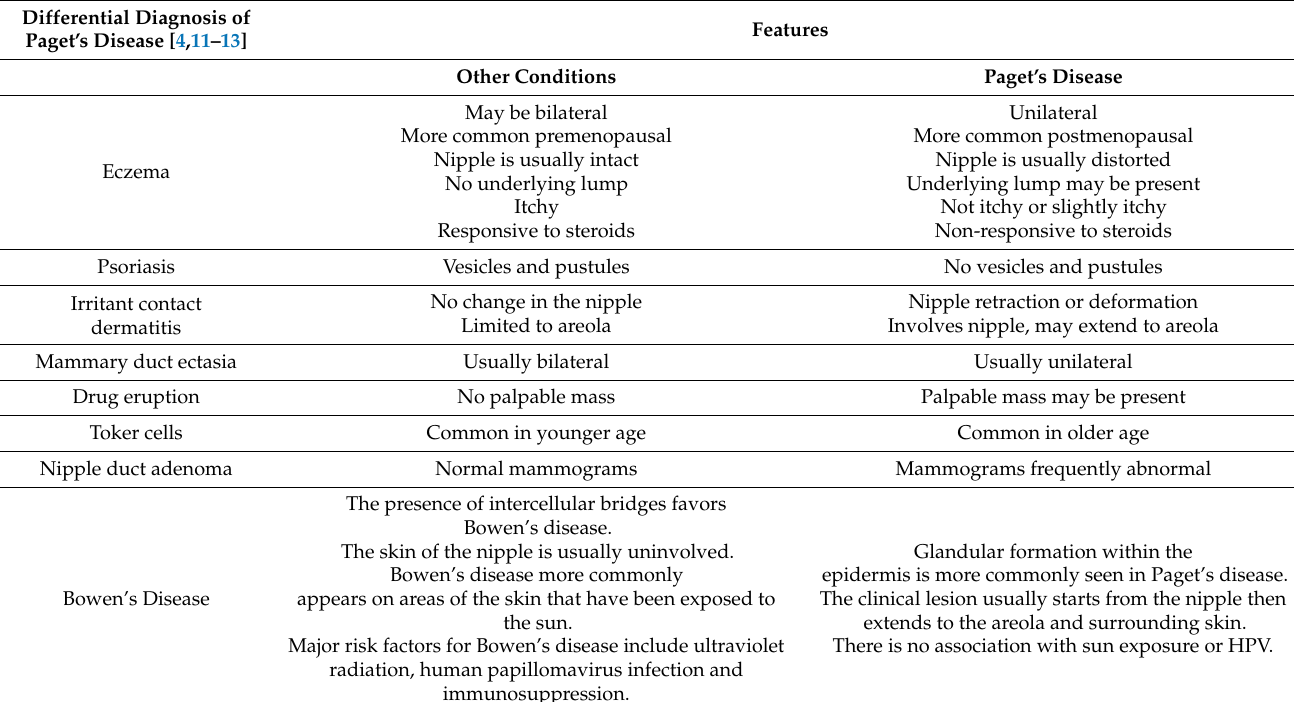
Table 2. Comparison between MPD and conditions affecting the nipple-areolar